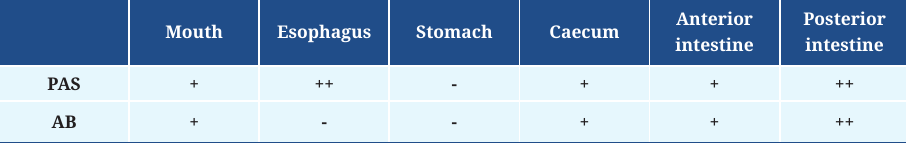
TABLE 1 | Qualitative analysis of epithelial mucous cells based on staining intensity to Periodic Acid- Schiff (PAS) and Alcian Blue (AB) pH = 2,5. (–) not stained, (+) poorly stained, (++) strongly